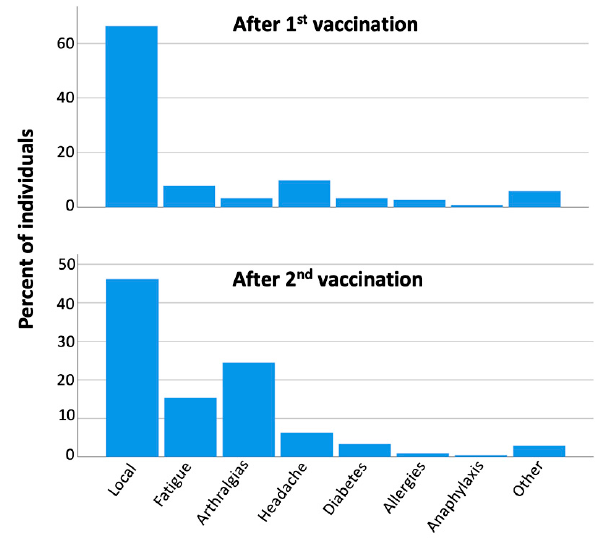
Figure 8. Type of adverse events after the first and second vaccination.